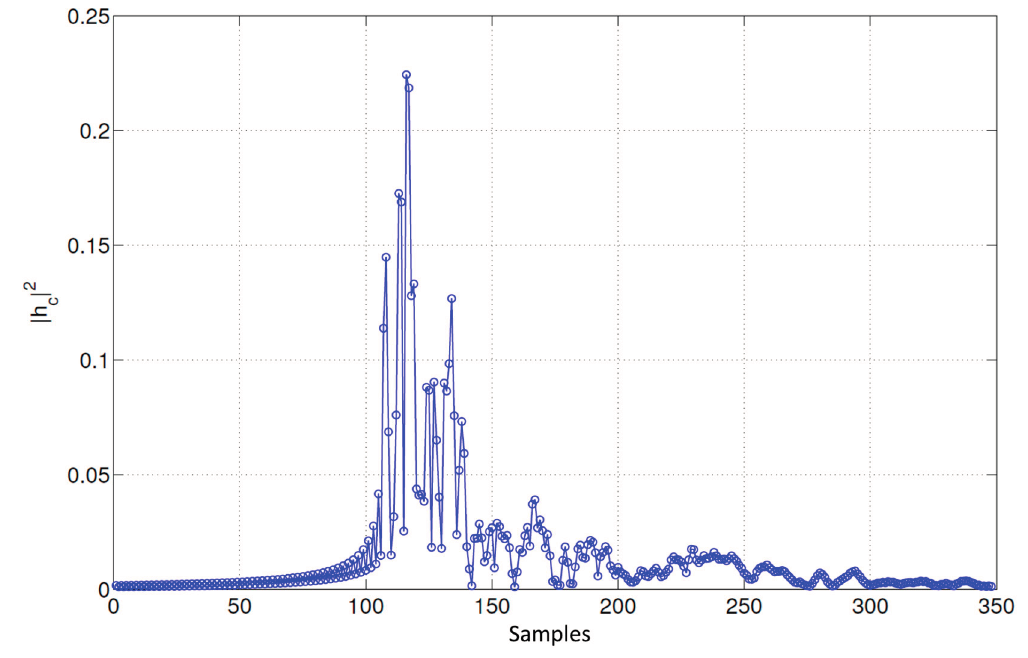
Figure 4. Module | h c | 2 of the Tonello PLC channel impulse